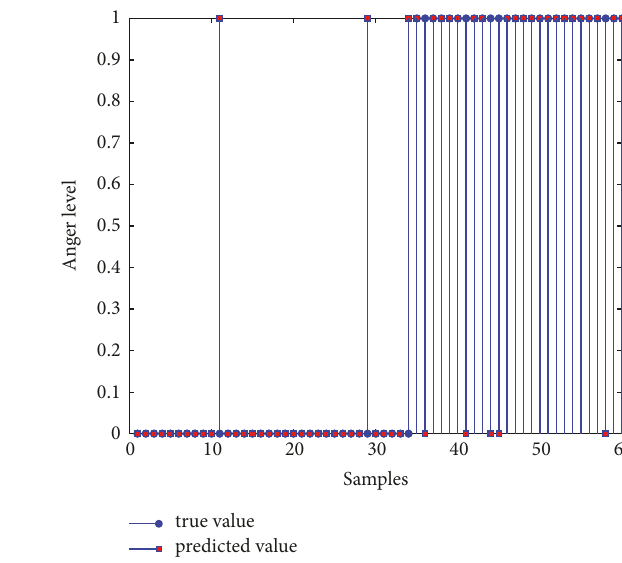
Figure 13: The ROC of training set.